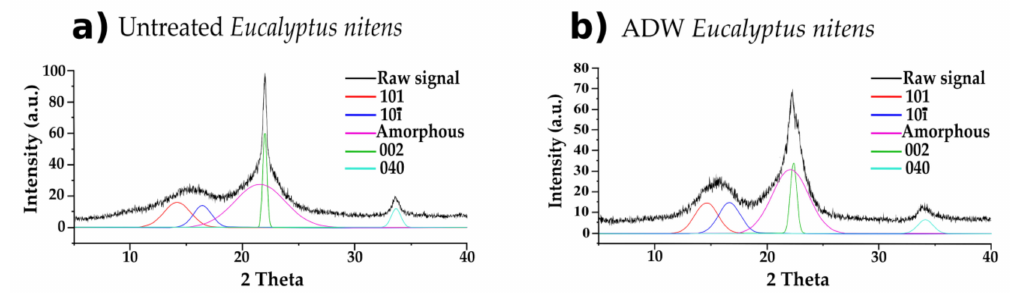
Figure 3. XRD spectra of ( a ) untreated and ( b ) autohydrolyzed-delignified wood (ADW) Eucalyptus nitens